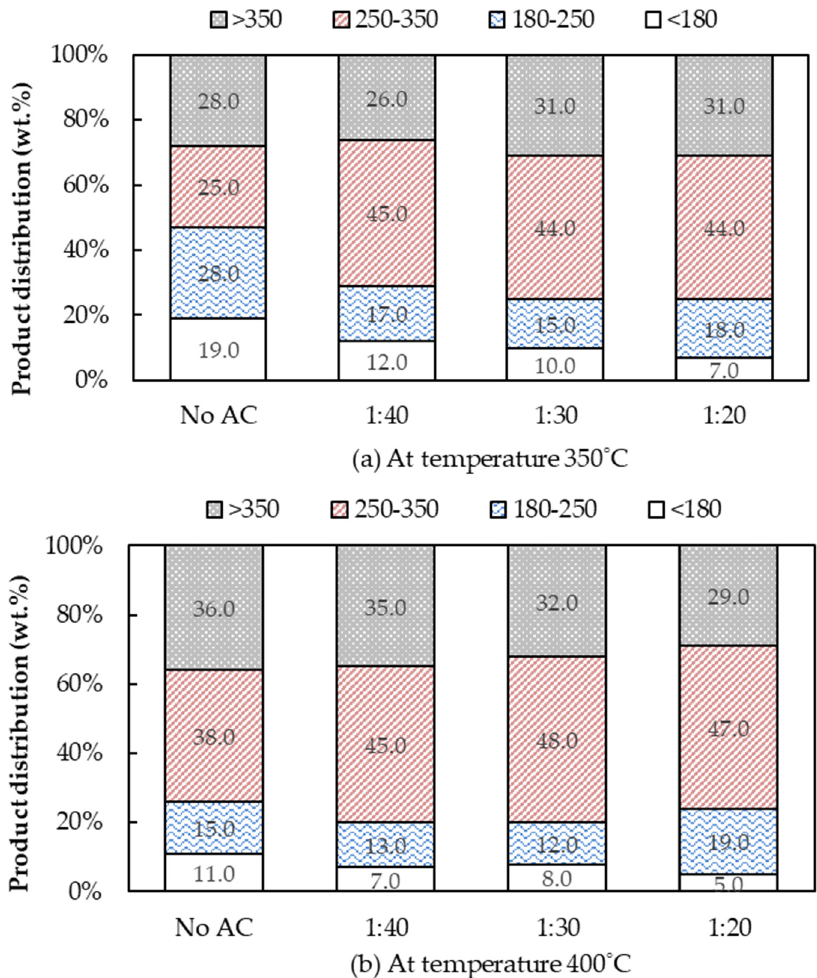
Figure 8. The boiling temperature distribution of the liquid bio-oil obtained from pyrolysis of WCO at various AC:WCO mass ratios. (Operating conditions: a flow rate of N 2 of 40 mL/L; a pyrolyzed temperature at 350 and 400 °C.)